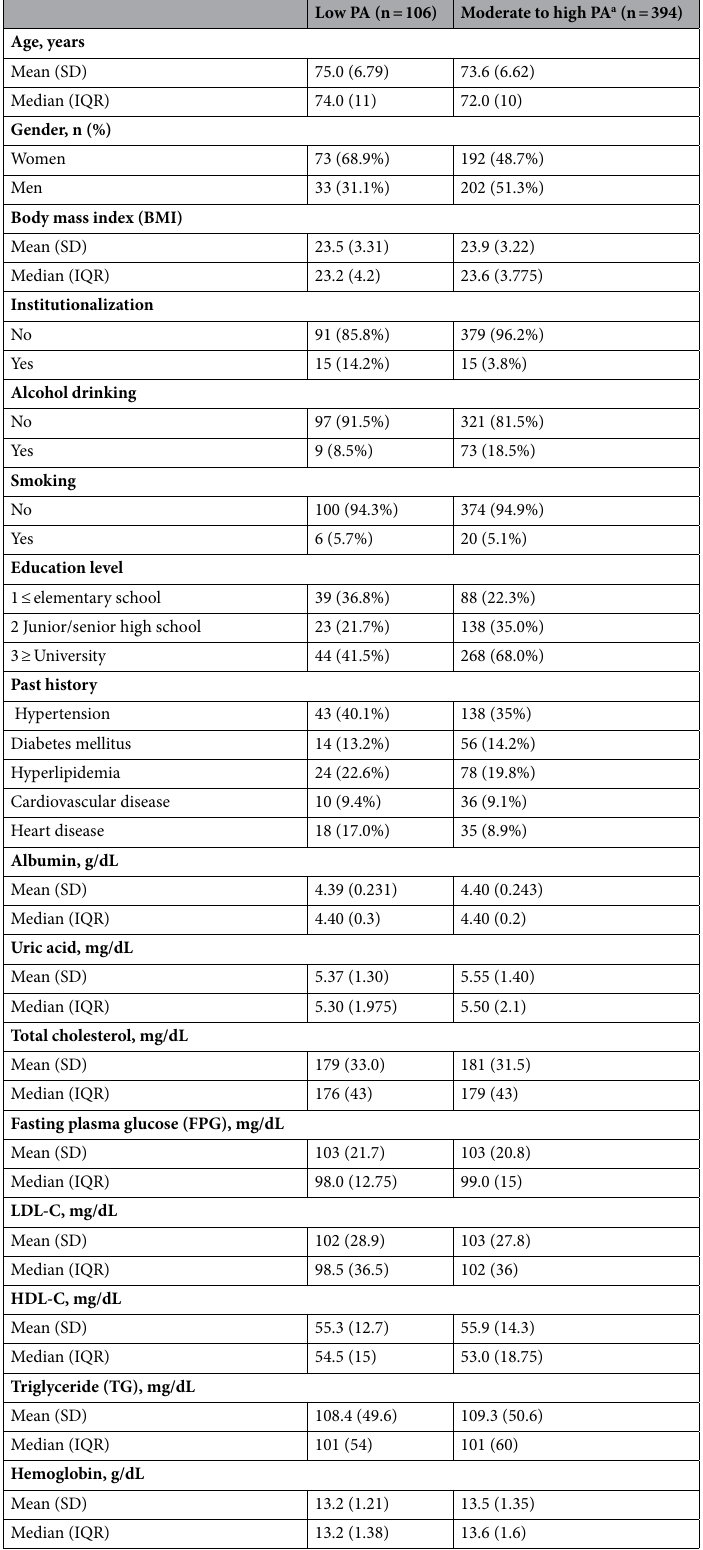
Table 1. Basic demographic and clinical characteristics of the study participants. PA physical activity, SD standard deviation, IQR interquartile range, LDL-C low-density lipoprotein cholesterol, HDL-C high-density lipoprotein cholesterol. a Physical activity level according to IPAQ